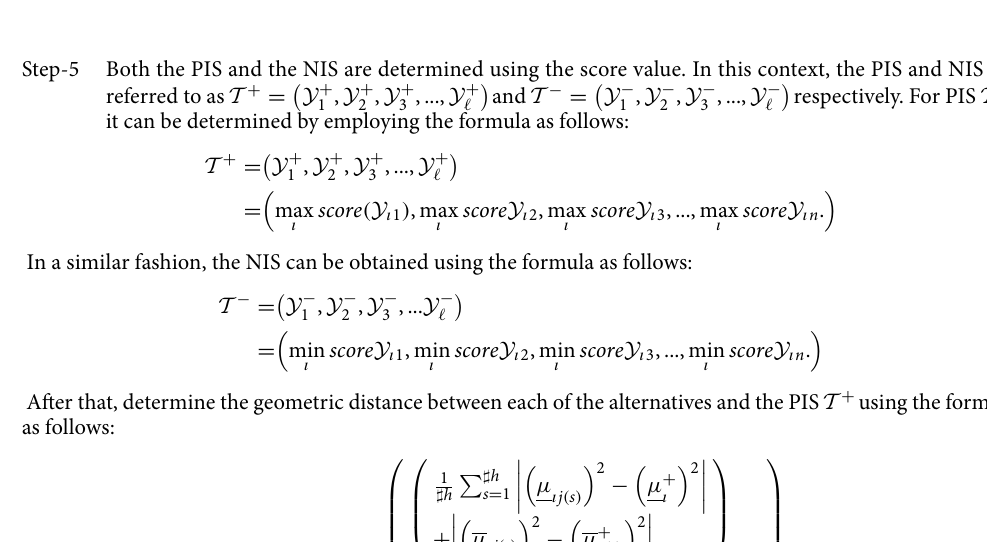
Figure 3. The graphical depiction of ranking according to the modified